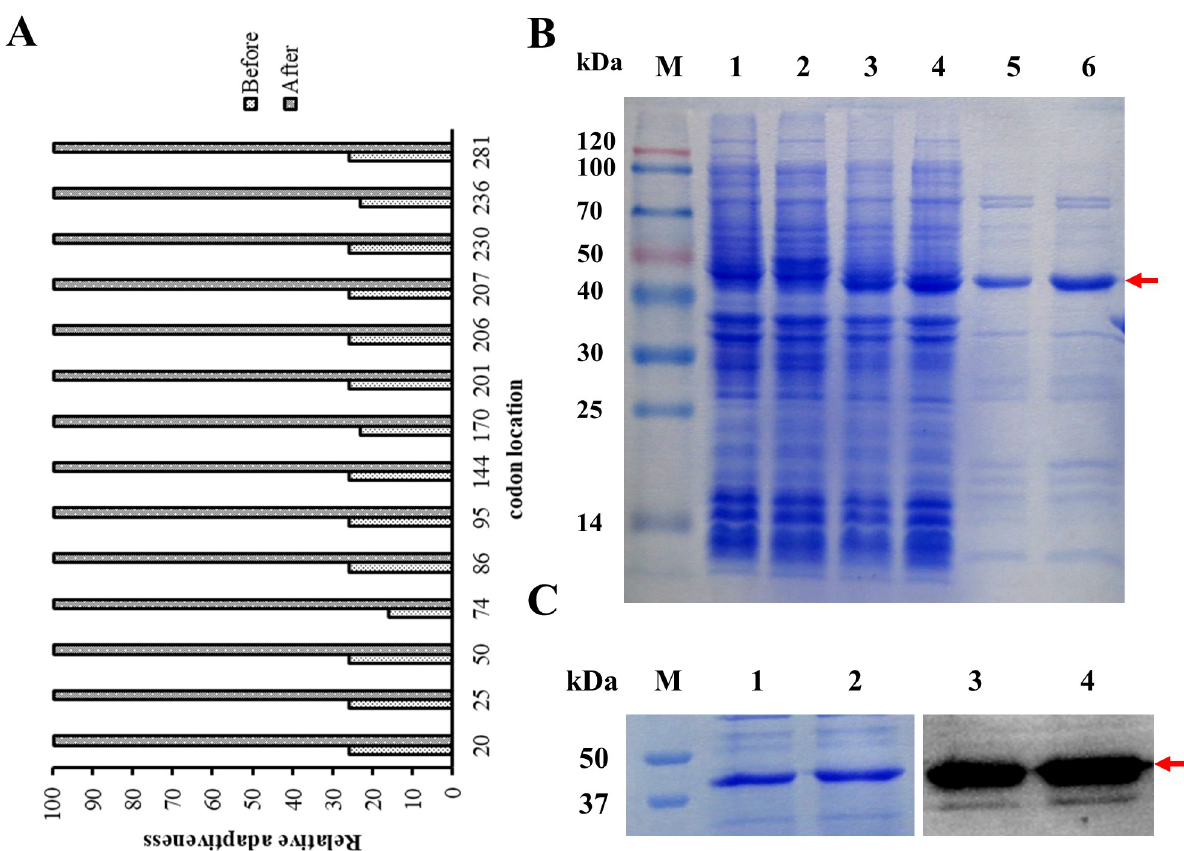
Fig 1. Cloning and expression of BCL6 1-350 in prokaryotic system. (A) The relative adaptiveness comparison of representative BCL6 1-350 codons between original and optimized sequence in E . coli . The relative adaptiveness analysis of BCL6 1-350 codons for original and optimized sequence was compared in S1 Fig. 14 codons of BCL6 1-350 were below 30% of relative adaptiveness, which were chosen for the comparison with the optimized codons of BCL6 1-350 . (B) Expression and Purification of BCL6 1-350 . E . coli containing indicated vector were cultured in LB medium at 37˚C. 3h further culture with IPTG induction or control was conducted for protein expression, when OD of E . coli reached 0.6 ~ 0.8. Then the expression profiles of E . coli were analyzed with SDS-PAGE analysis. M: Marker (Blue plus II protein marker); lane 1: expression profile of E . coli containing control vector; lane 2: expression profile for BCL6 1-350 expression vector without induction; lane 3–4: the duplicate expression profile for BCL6 1-350 vector after IPTG induction, lane 5–6: the duplicate of BCL6 1-350 after purification. (C) Western blot result of BCL6 1-350 . M: Marker (Precision Plus Protein Dual color standards). The purified BCL61-350 protein was resolved by 10% SDS-PAGE, and then transferred into PVDF membrane for immunoblot with